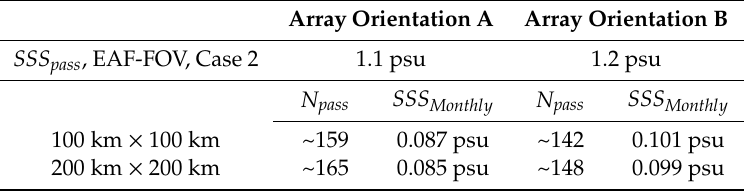
Table 4. Estimation of monthly SSS accuracy for di ff erent array orientations.